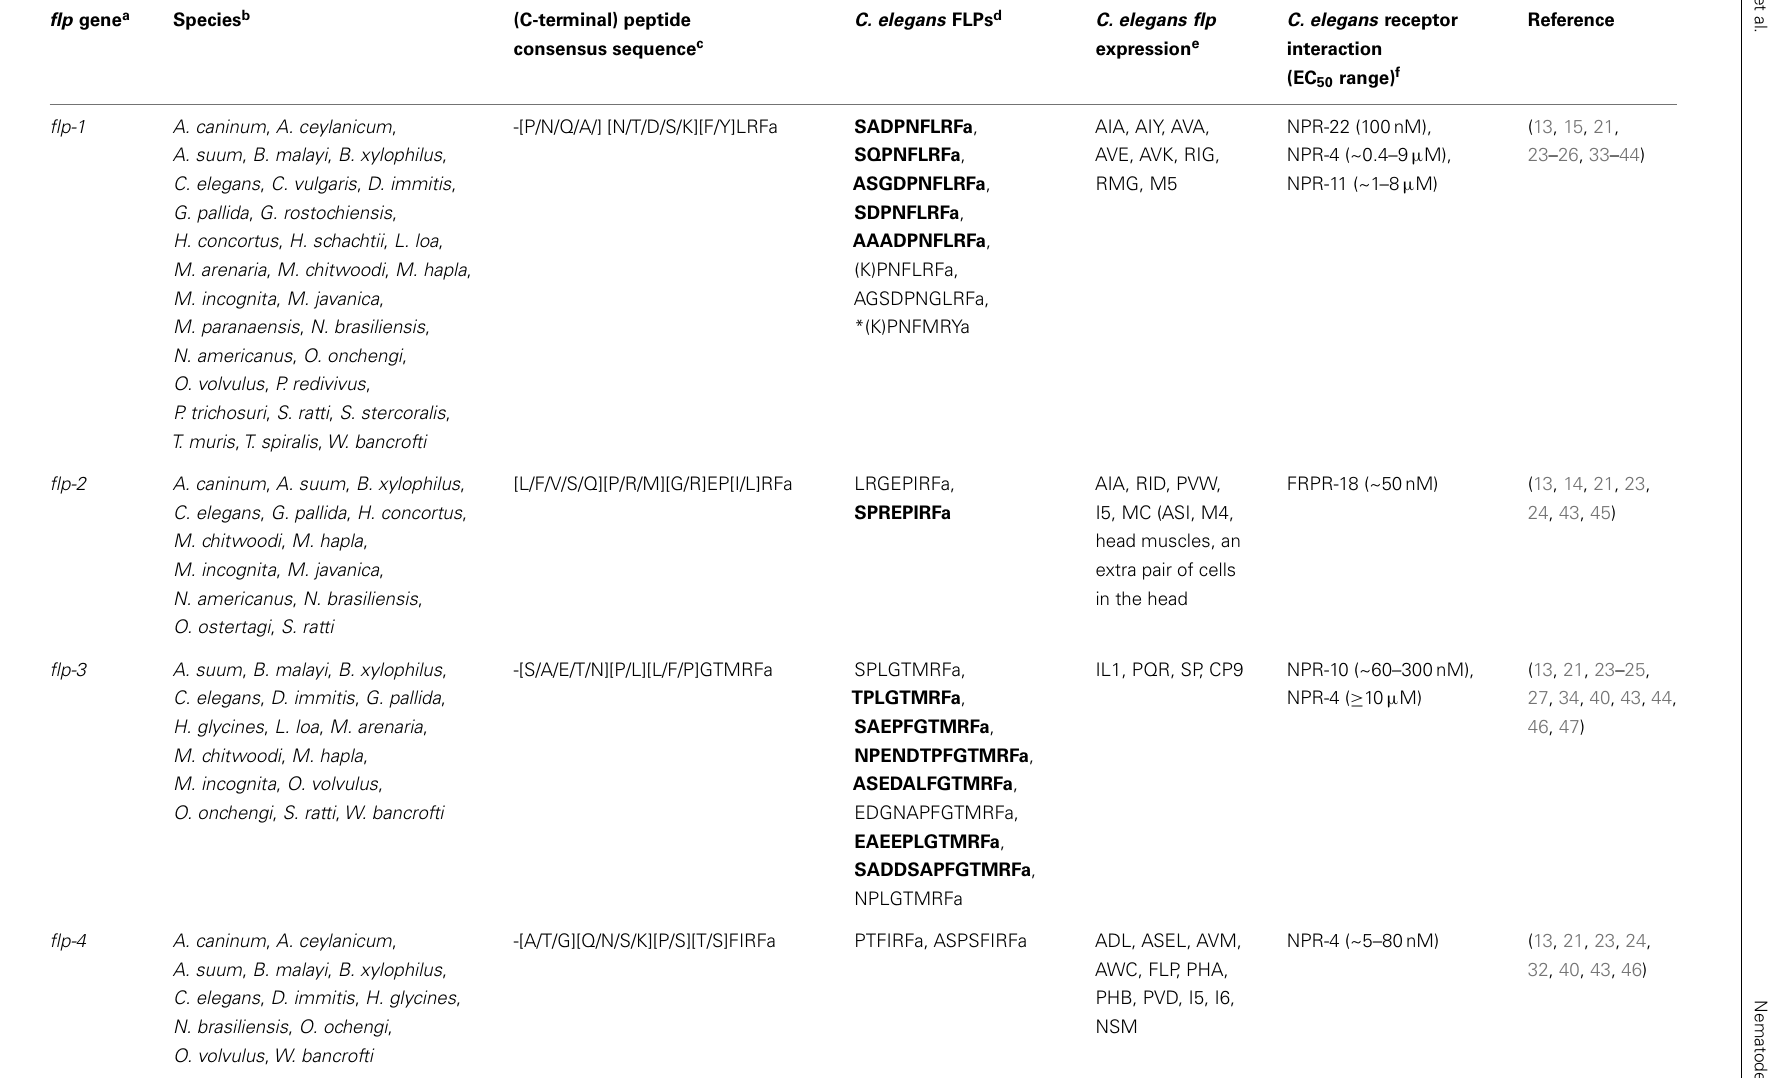
Table 1 | Neuropeptide genes encoding FLPs in nematodes